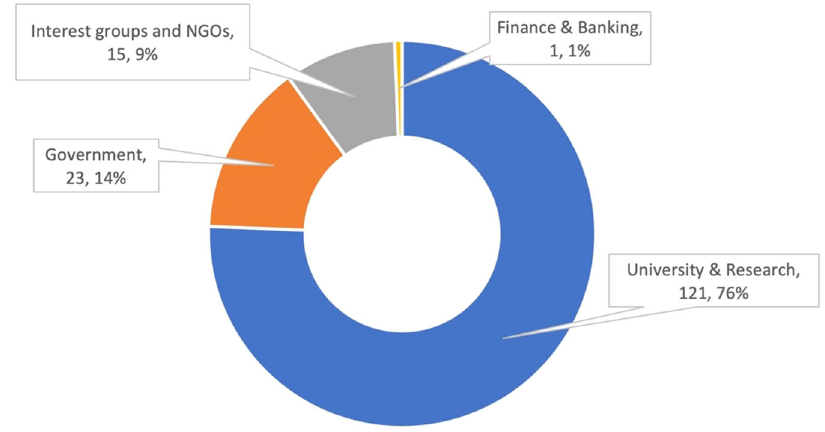
Fig. 4 Institutional distribution of rice researchers in Indonesia and the Philippines, n = 160 institutions. The majority of rice researchers in Indonesia and the Philippines have af fi liations with “ University and research ”